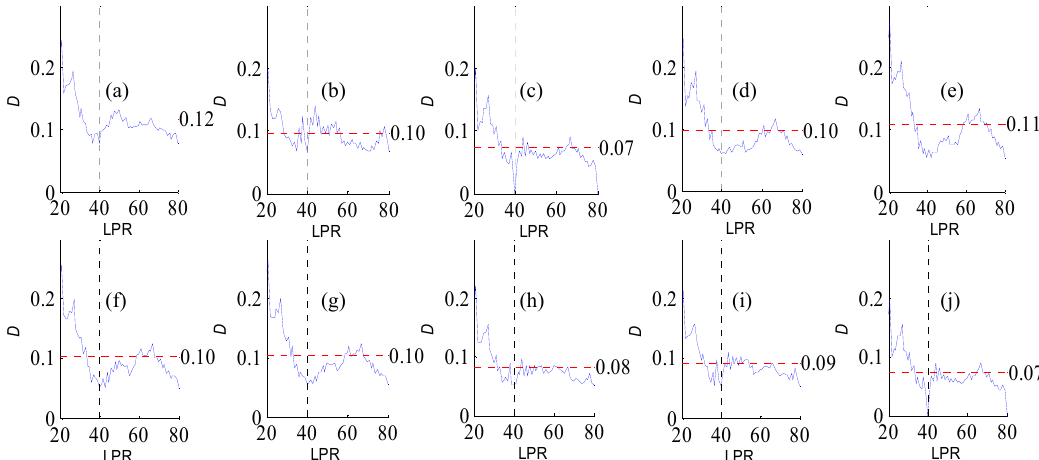
Figure A32. Variation of flow regime alteration degree (D) measured by the RVA with change in the length of post-impact flow time series (LPR) under a periodicity of 40 years. ( a – j ) correspond to pre-impact flow time series length = 29, 34, 40, 46, 51, 57, 63, 69, 74, and 80 years, respectively. The abscissa value for the vertical dotted line is 40. The ordinate value for the horizontal dotted line is the mean degree of flow regime alteration in each subfigure.